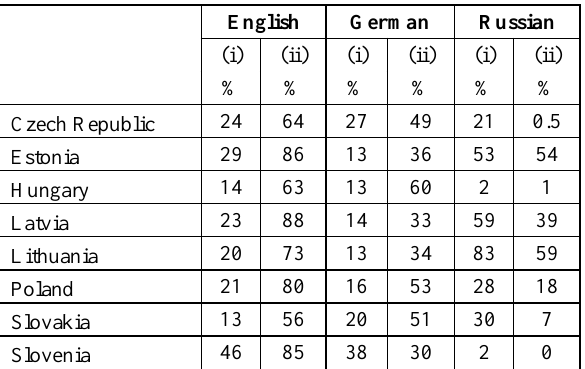
Table 13. Foreign languages percentage who speak